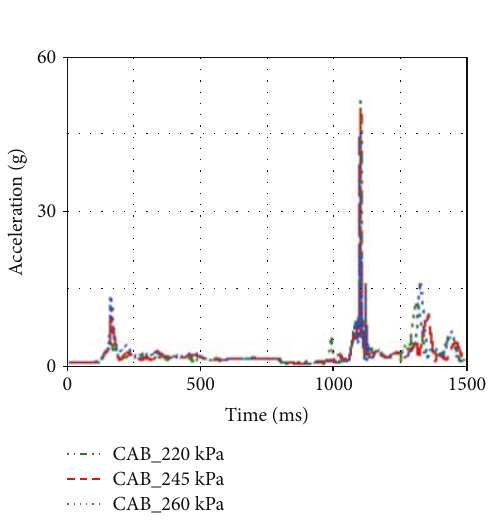
Figure 16: Head accelerations of di ff erent in fl ators.